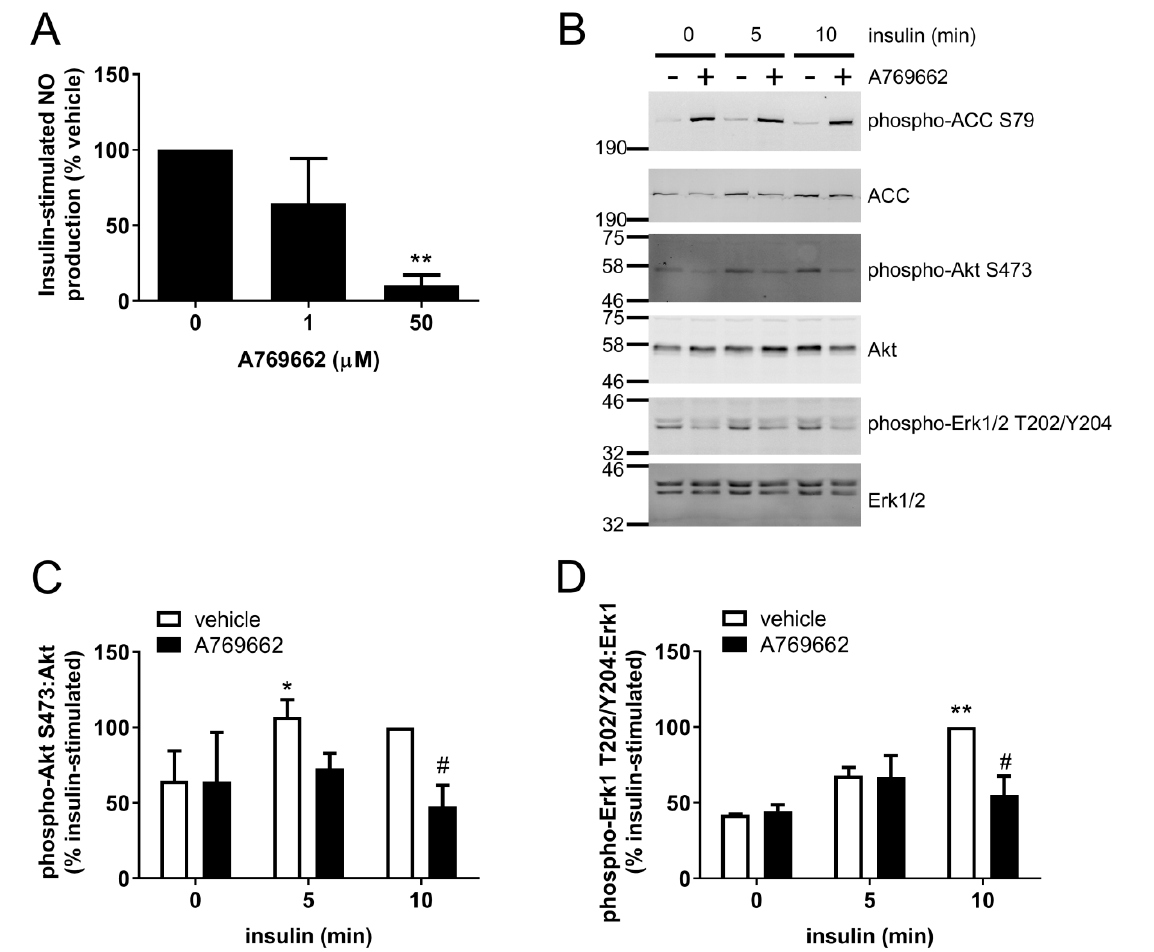
Figure 5. The effect of A769662 on insulin-stimulated NO synthesis and signalling in HAECs. ( A ) HAECs were stimulated with the indicated concentrations of A769662 prior to insulin stimulation (1 µM, 15 min). Conditioned media was collected and NO production assessed. ( B – D ) HAECs were incubated with 50 µM A769662 for 45 min prior to insulin stimulation (1 µM) for the indicated durations. Cell lysates were prepared and immunoblotted with the antibodies indicated. ( B ) Representative immunoblots from three independent biological replicates with molecular weight markers indicated. ( C , D ) Densitometric quantification (mean ± SEM) of ( C ) Akt Ser473 or ( D ) Erk1 Thr202/Tyr204 phosphorylation normalised to total Akt or Erk1 levels respectively (mean ± SEM). * p < 0.05, ** p < 0.01 relative to absence of insulin. # p < 0.05, relative to absence of A769662.